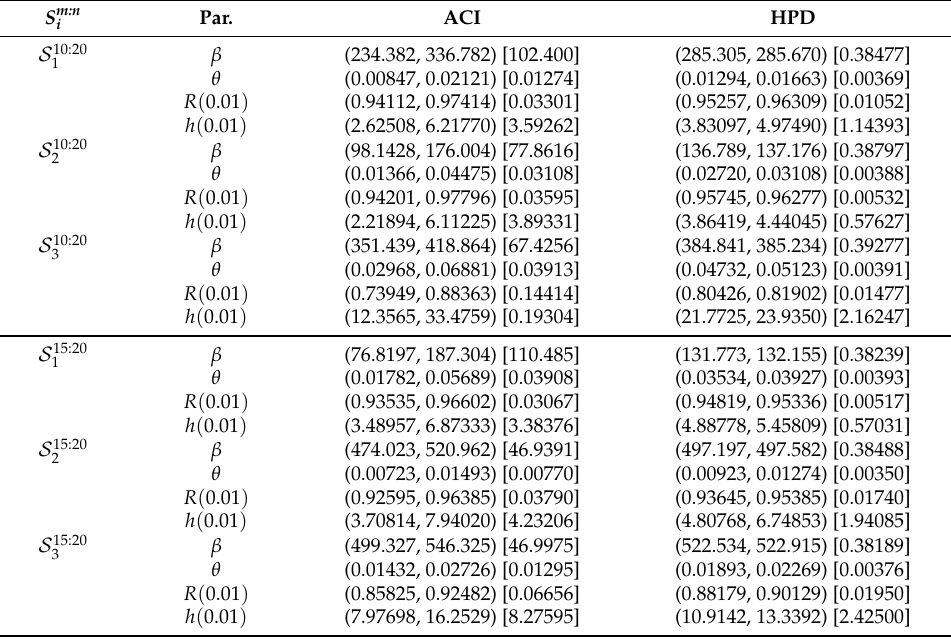
Table 7. The 95% interval estimates (ILs) of β , θ , R ( t ) , and h ( t ) under SSB